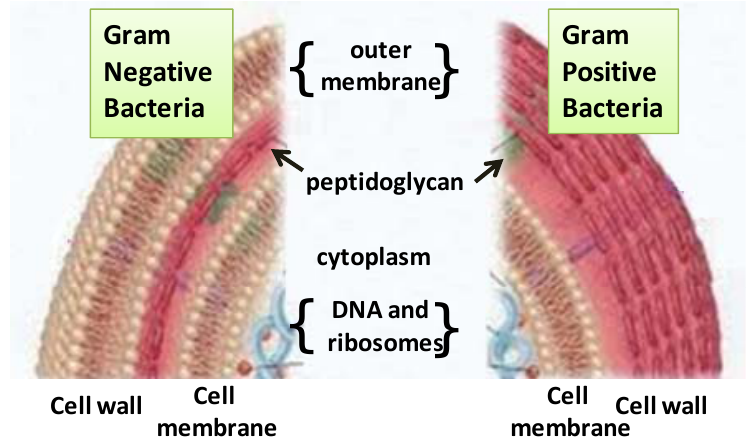
Figure 1. Schematic of the envelopes of Gram-positive (on the right) and Gram-negative bacteria (on the